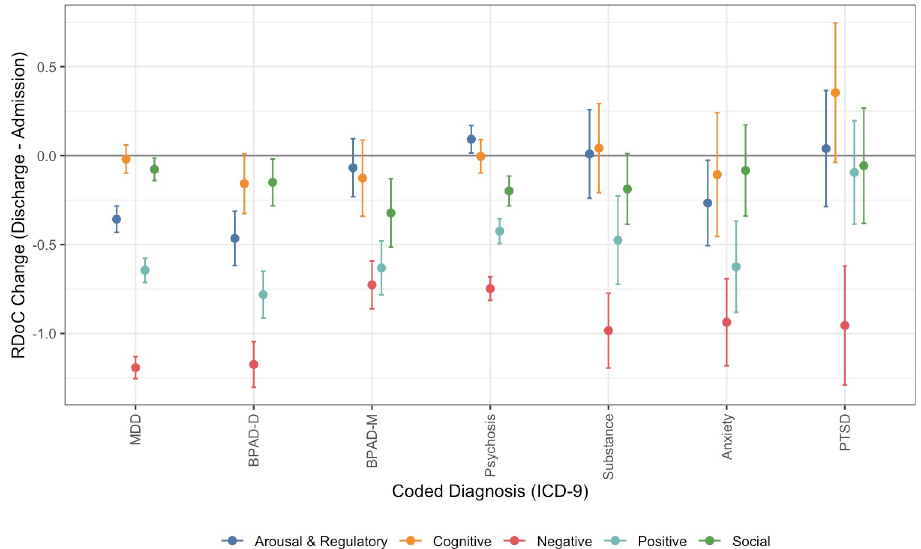
Fig 1. Average changes in estimated Research Domain Criteria scores between admission and discharge by ICD9 categorical diagnosis. Bars indicate 95% confidence intervals. MDD = major depressive disorder; BPAD-D = bipolar affective disorder, depression; BPAD-M = bipolar affective disorder, mania/mixed; PTSD = post-traumatic stress disorder.